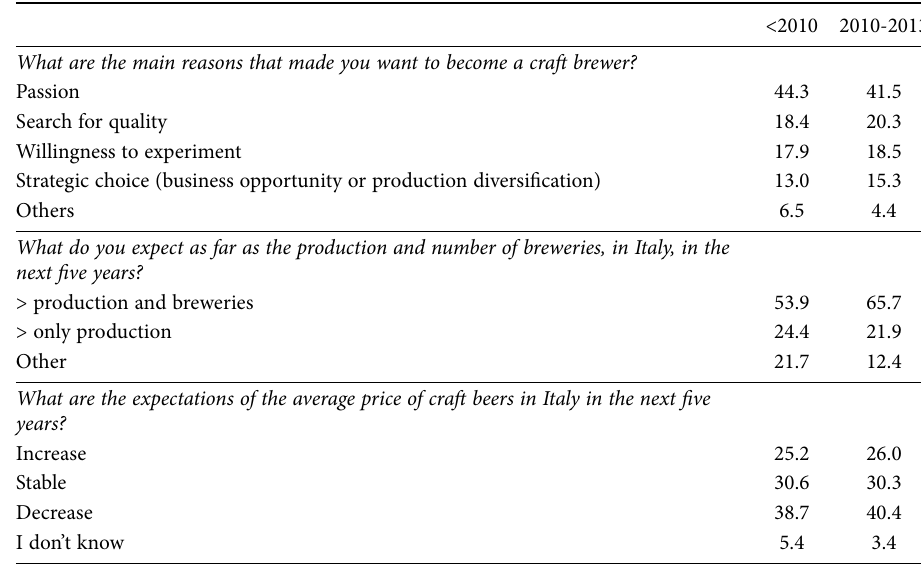
Table 4. Comparison of survey responses between breweries founded before and after 2010